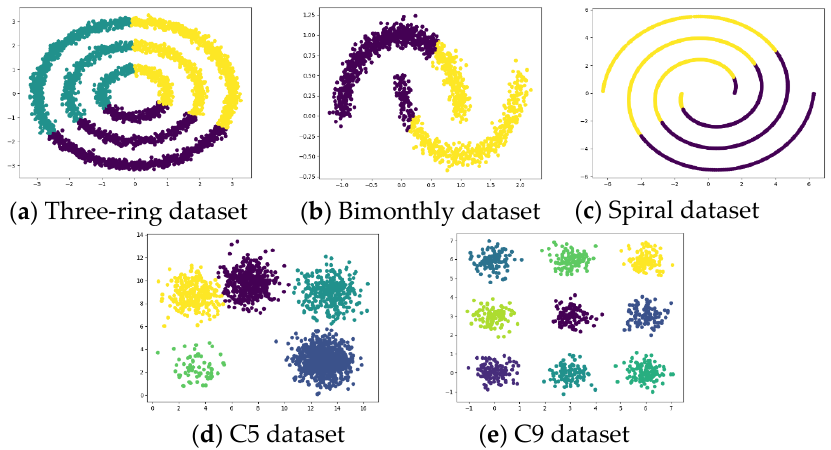
Figure 3. Clustering results of the k-means algorithm on artificial datasets.